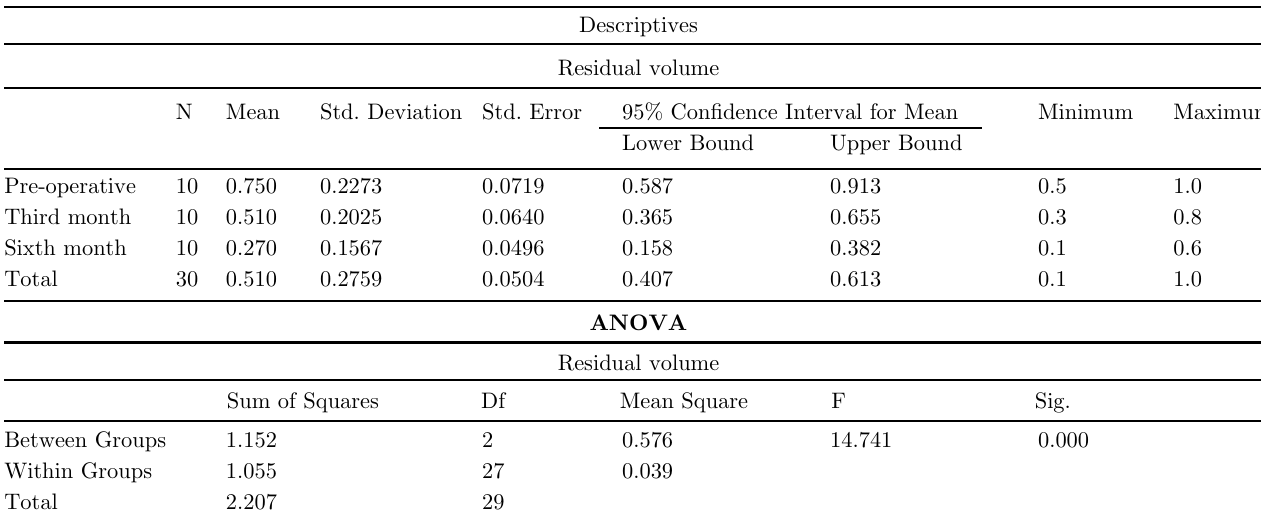
Table 2. One-way ANOVA analysis for Cleft defect volume at different time